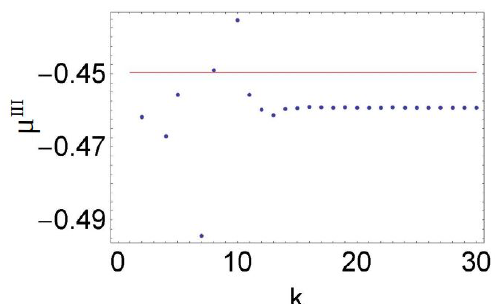
Figure 6. The phase µ III (blue dots) in the nonadiabatic case of Figure 4 obtained from the numerically computed wavefunction φ ( x , t ) as the basis size increases (cf. Equation (16)). It is seen that states ψ II to at least k = 15 are necessary in order for the computed value of µ III to converge. The solid red line represents µ I , the phase increment in Case I. The quantity that displays nonlocality here is the phase difference between Cases III and I (the blue dots and the red line), ∆ µ = µ III − µ I